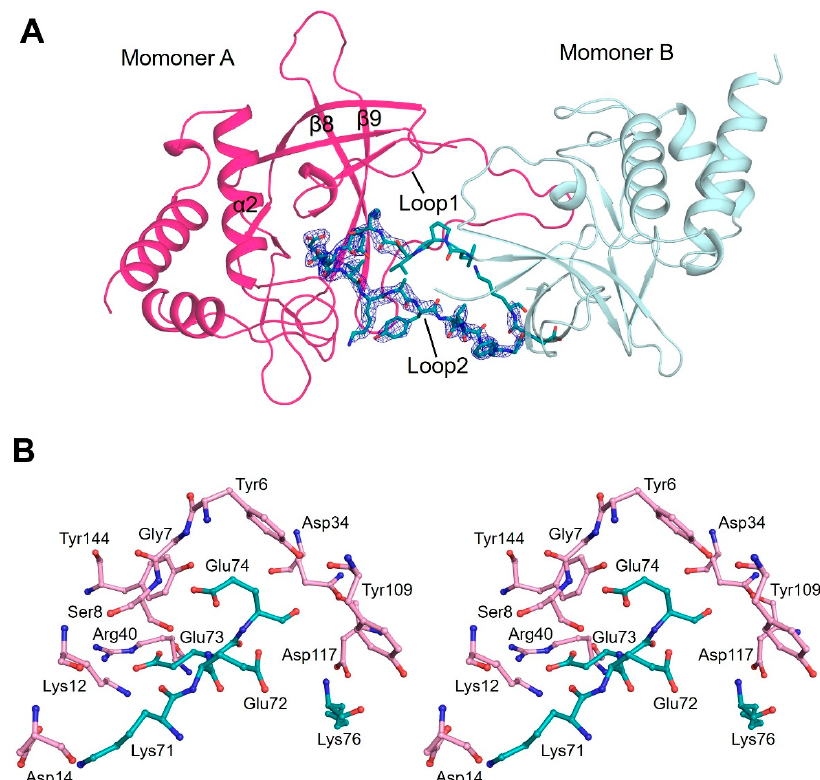
Figure 2. Open conformation of ChaC2. ( A ) Crystallographic ChaC2 dimer with long flexible loop2. Two ChaC2 monomers are colored in pink and pale cyan, respectively. The loop2 residues are represented as green stick models and their 2 mFo - DFc electron densities of 2.0 σ are shown with blue meshes. ( B ) A stereo-view of the dimeric interface of ChaC2. The residues from the two interacting ChaC2 molecules are denoted with pink and cyan models, respectively. The nitrogen and oxygen atoms are denoted in blue and red, respectively.